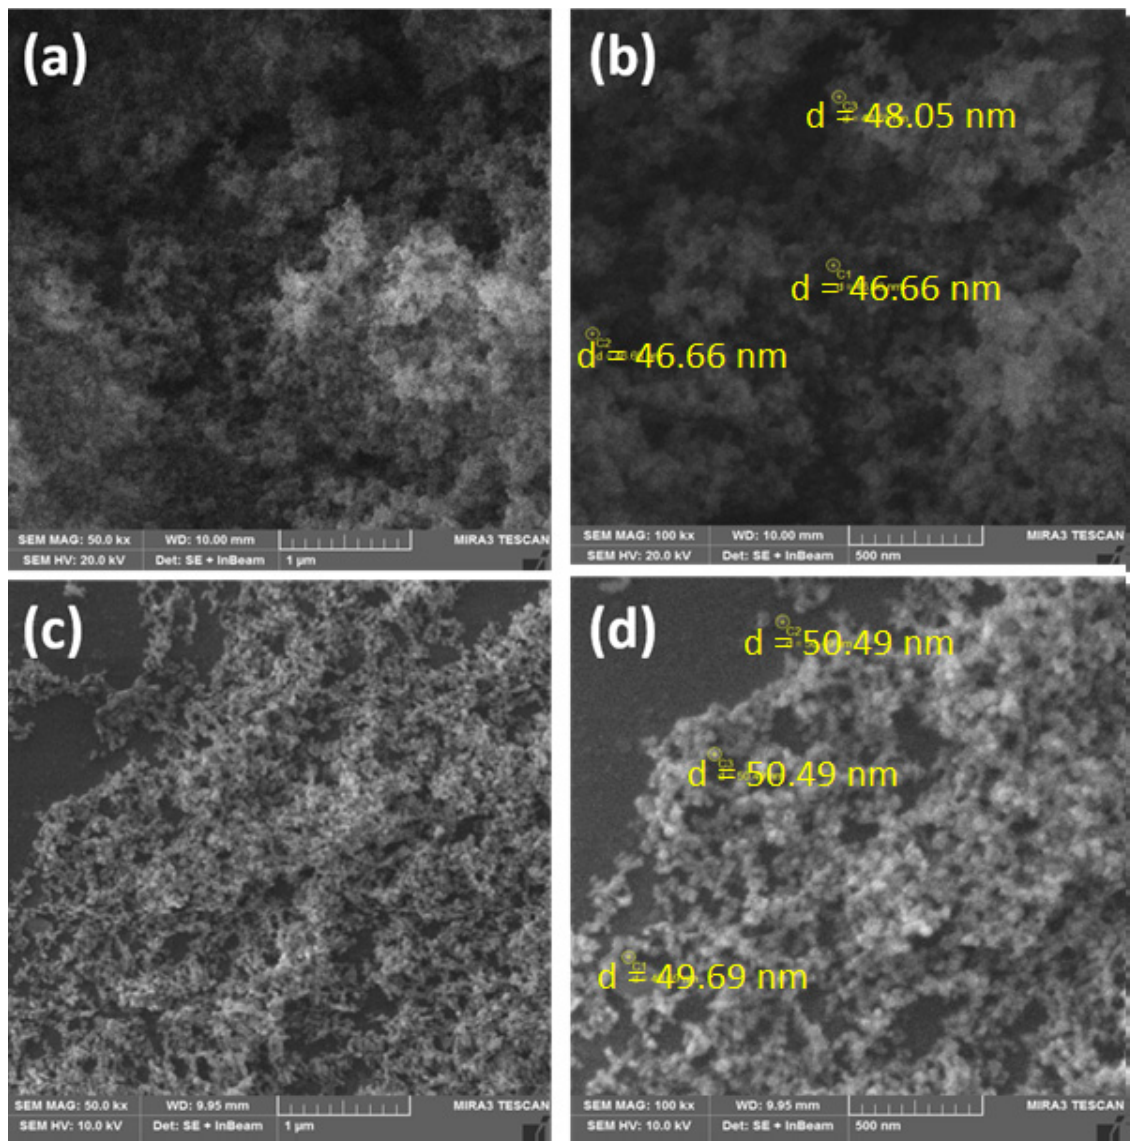
Figure 2. FESEM images of ( a , b ) NZF ( c , d ) and NZF@NF.